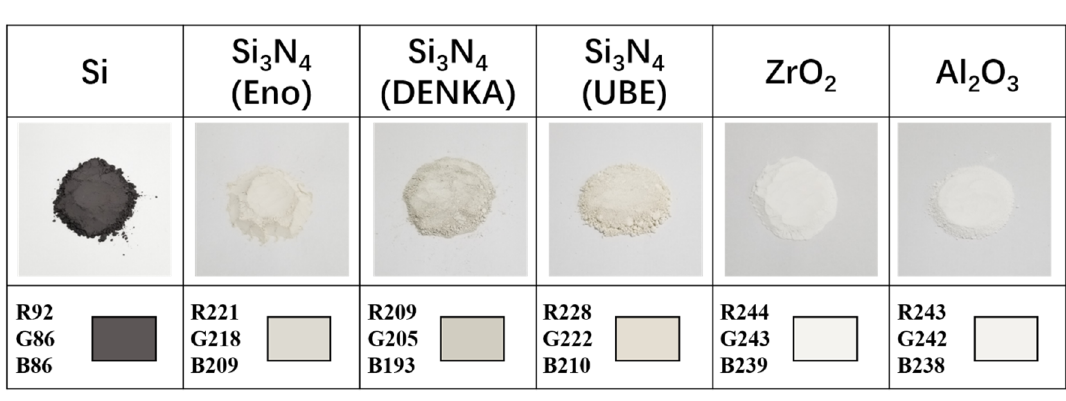
Figure 5. Colors and RGB values of raw powders.